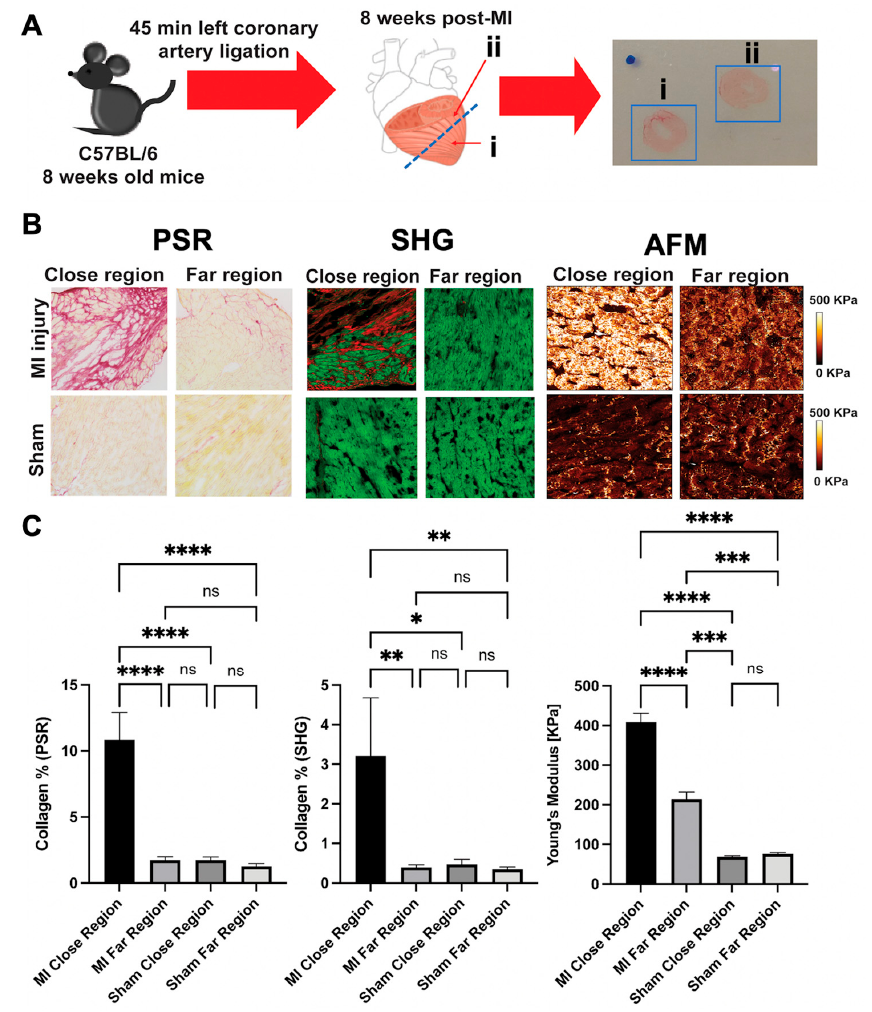
Figure 9. Comparison between Picrosirius Red staining (PSR), SHG, and AFM as techniques to detect fibrosis. ( A ) representative diagram of the sample collection: Eight weeks post-MI, hearts were harvested, cut in two halves, and cryogenically sectioned. Two sections on the hearts were analyzed. (i) One section was located close to the MI region (close region) and (ii) one section was located in the far MI region (far region). ( B ) Representative images of the hearts analyzed by Picrosirius Red staining, SHG and AFM techniques. ( C ) Quantification of collagen by Picrosirius Red staining and SHG and quantification of tissue stiffness by AFM: no significant differences in collagen deposition were observed between the MI far region and the sham (close and far regions); however, significant differences on tissue stiffness (Young’s modulus), analyzed by AFM, were observed between the MI far region and the sham (close and far regions). PSR: MI close region vs. MI far region **** p < 0.0001; MI close region vs. sham close region **** p < 0.0001; MI close region vs. sham far region **** p < 0.0001. ns: non-significant. SHG: MI close region vs. MI far region ** p : 0.0096; MI close region vs. sham close region * p : 0.0126; MI close region vs. sham far region ** p : 0.0082. AFM: MI close region vs. MI far region **** p < 0.0001; MI close region vs. sham close region **** p < 0.0001; MI close region vs. sham far region **** p < 0.0001; MI far region vs. sham close region *** p : 0.0005; MI far region vs. sham far region *** p :